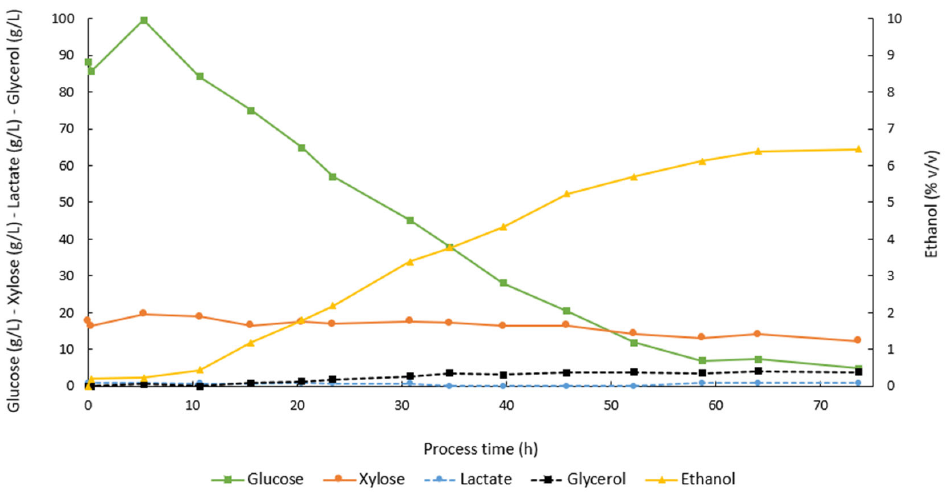
Figure 4. Course of an SSF process on 150 L scale .